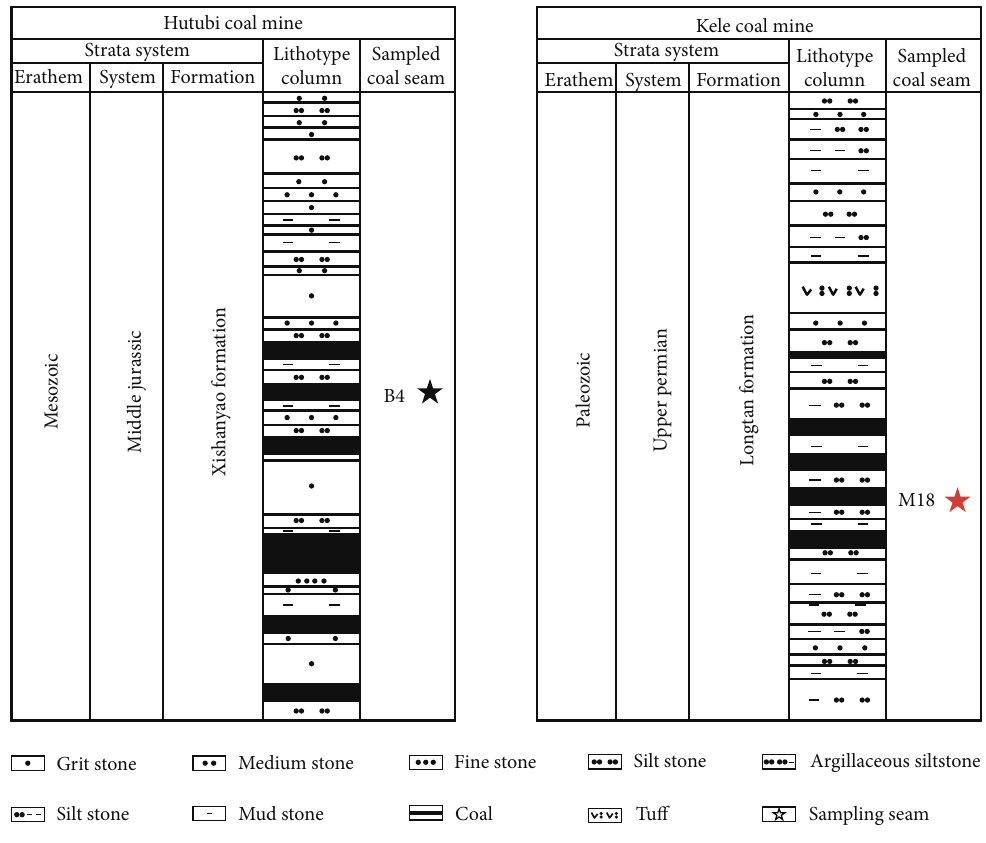
Figure 2: Stratigraphic columns and markers of sampling coal seams of the two coal Table 1: Basic characteristics of the coal samples with di ff erent particle sizes.